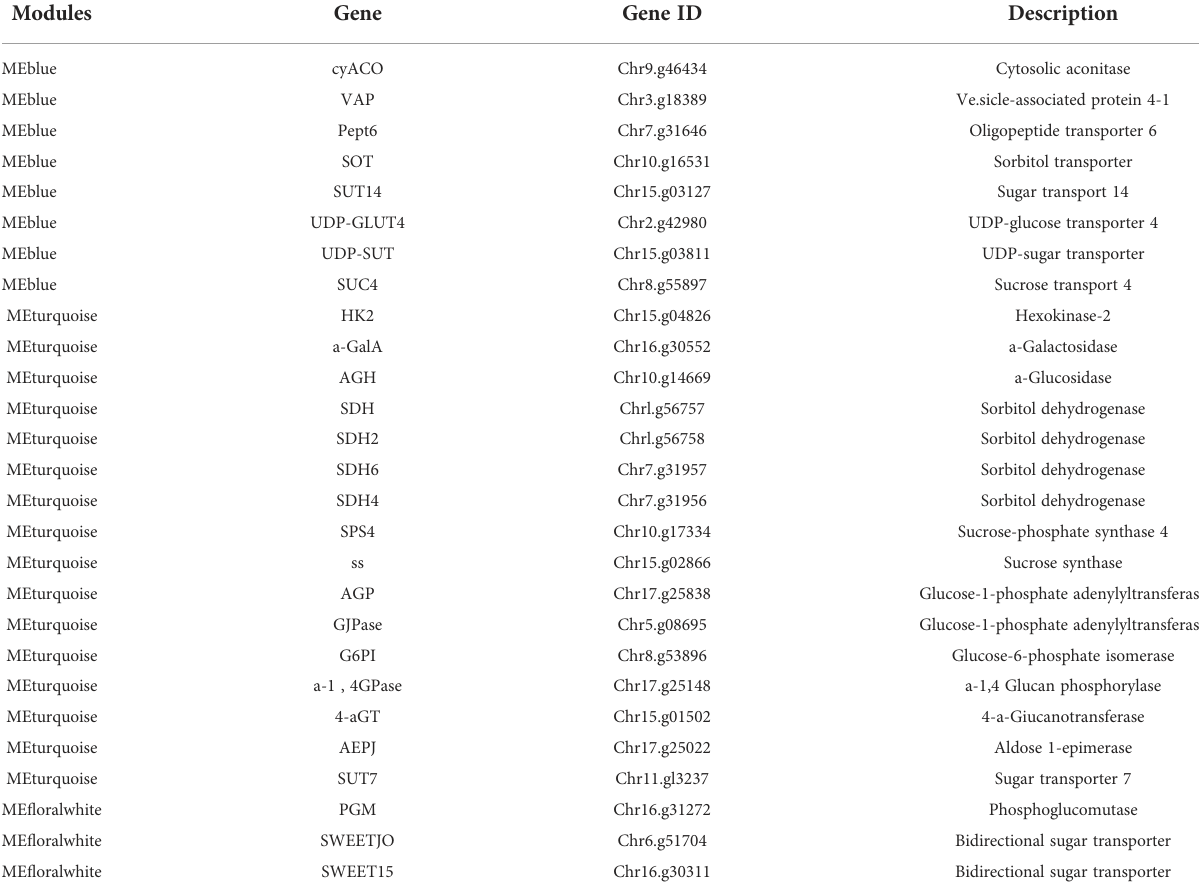
TABLE 1 Candidate hub genes for regulation of sugar and organic acid metabolism in the MEBlue, MEturquoise and ME fl oralwhite modules.